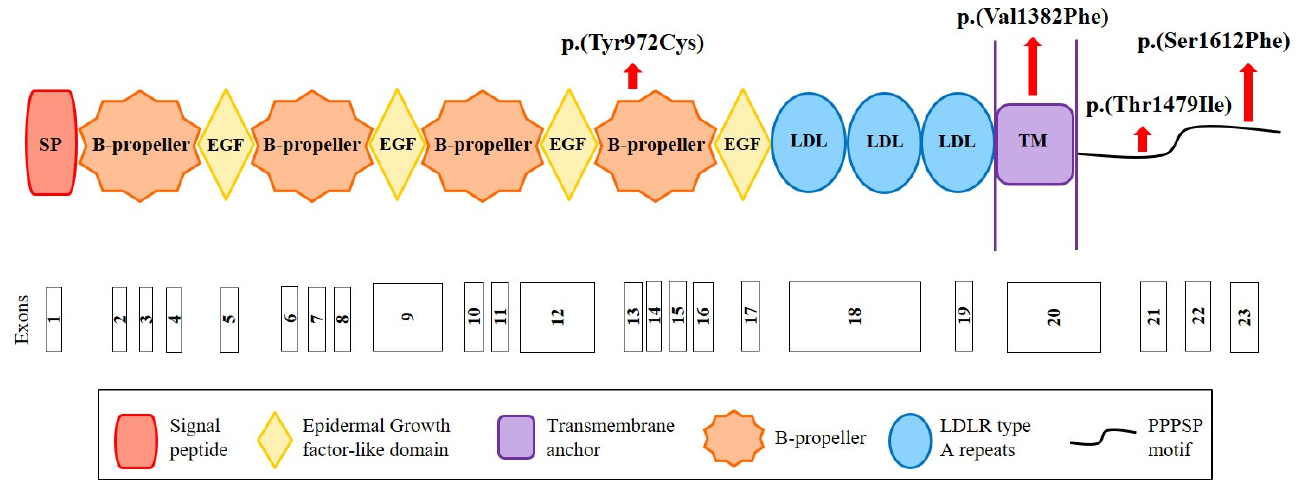
Figure 2. Structure of the LRP6 receptor and position of the identified variants. The LRP6 receptor contains the following structural motifs: signal peptide (SP), 4 β -propeller domains, 4 EGF-like domains (involved in the pH-dependent release of ligands in endosome), 3 LDLR type A repeats (responsible for the binding of ligands), a transmembrane anchor (binds the receptor to the cell membrane), and a cytoplasmic domain with PPPSP motifs (2 motifs at position 1487 and 1604 that allow the receptor to function in the Wnt/ β -catenin pathway). Red arrows indicate the position of the variants identified in this study. Figure built from data from UniProt (www.uniprot.org